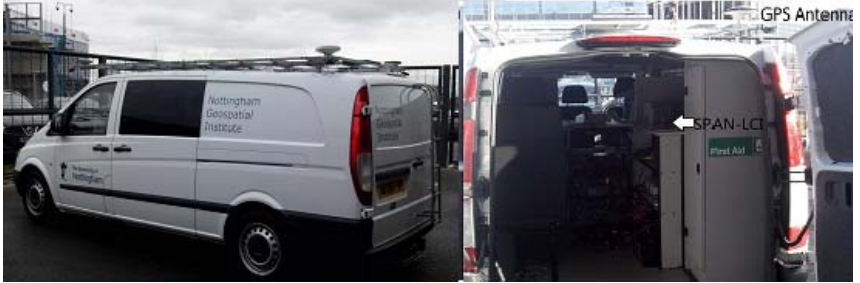
Figure 6. The testing